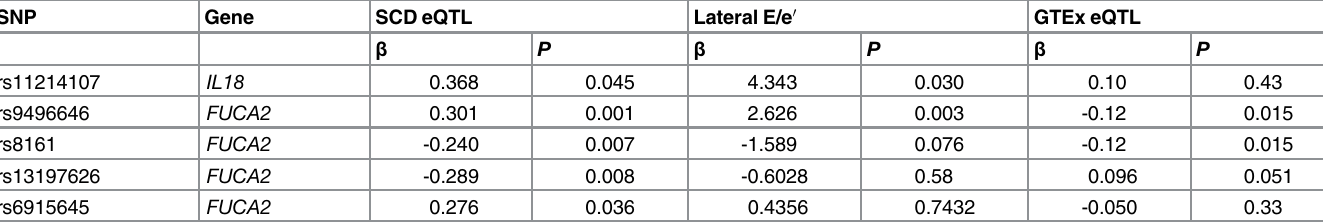
Table 3. Cis-eQTL and genetic associations with E/e 0 within the IL18 and FUCA2 gene regions. SNP Gene SCD eQTL Lateral E/e 0 GTEx eQTL β P β P β